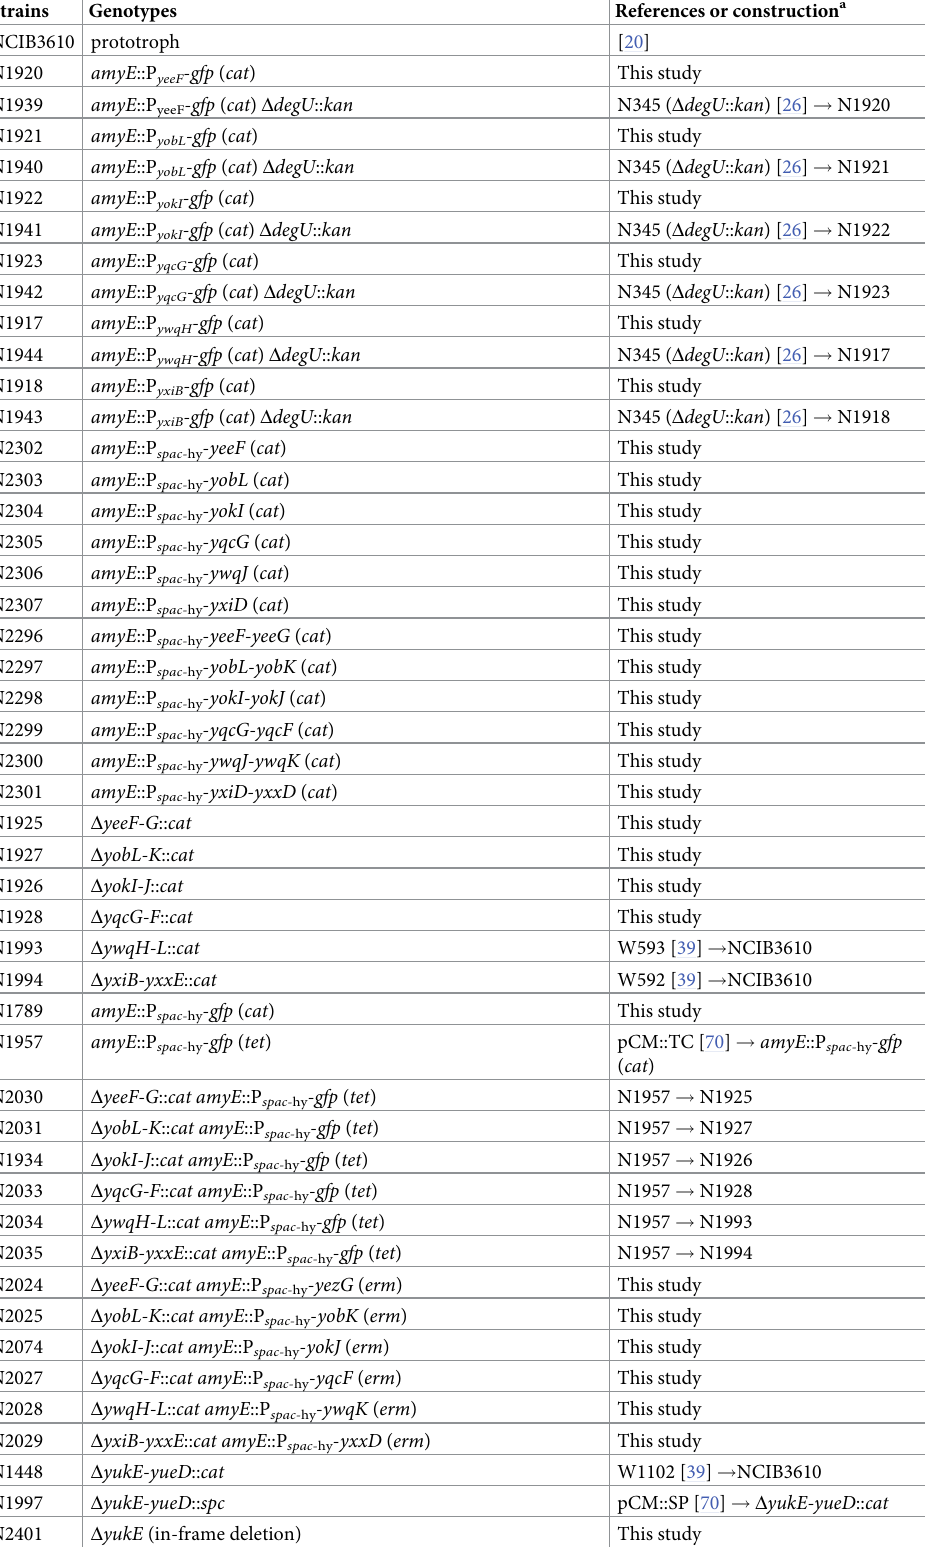
Table 3. B . subtilis strains used in this